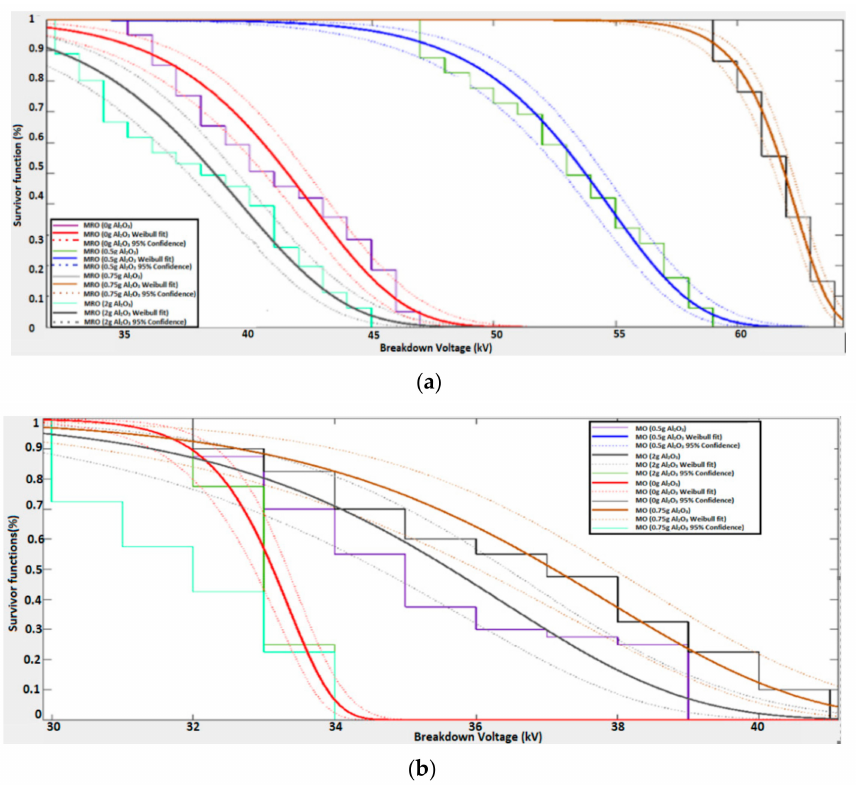
Figure 10. Survivor breakdown voltage function in different concentration of the Al 2 O 3 with Weibull fit showing the 95% confidence, ( a ) MRO, ( b )